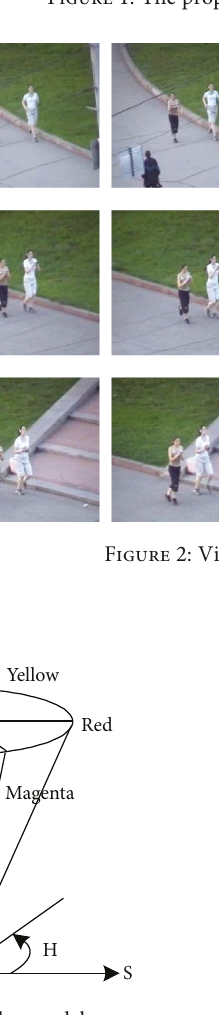
Figure 1: The proposed fractal compression process.